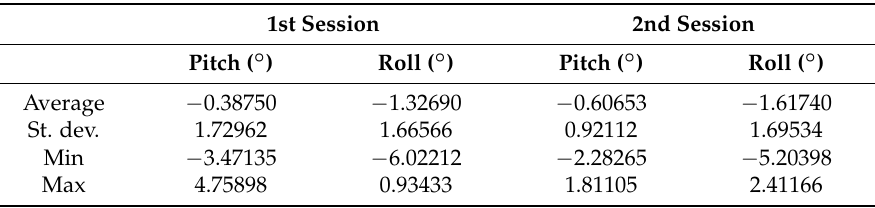
Table 4. Statistics for both sessions of outdoor flight.